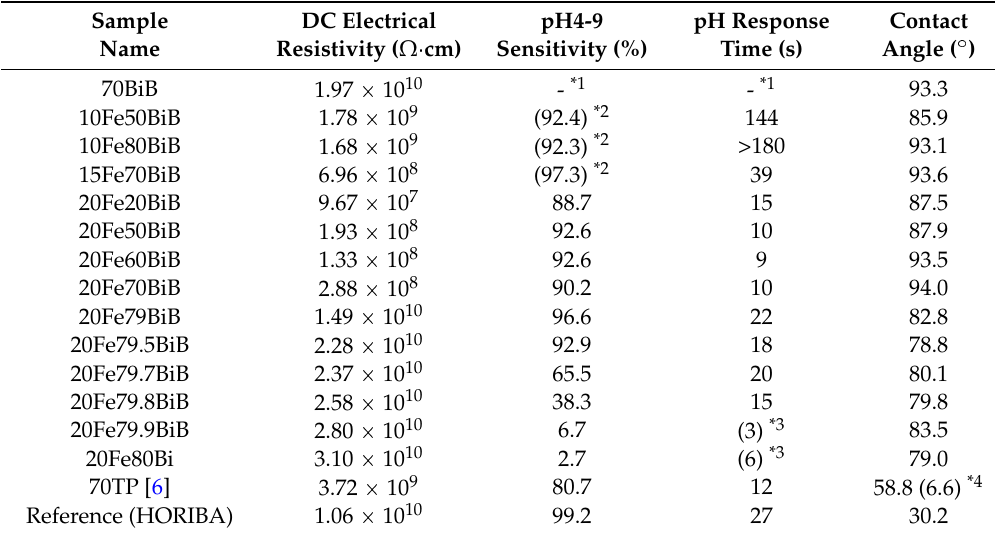
Table 1. DC electrical resistivity, pH4-9 sensitivity, pH response time and contact angle for 20Fe y BiB glasses and related glasses.